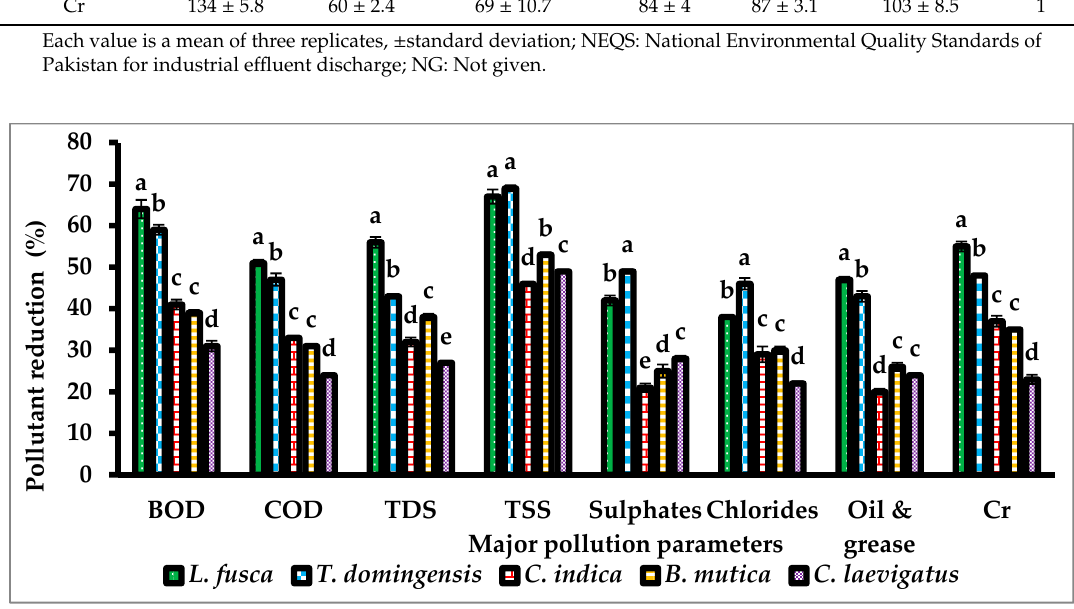
Figure 3. Pollutant reduction in tannery effluent by different macrophytes in constructed wetlands. Error bars indicate standard deviation among three replicates. Labels (a)–(e) indicate statistically significant differences ( p < 0.05) among plant species at a 5% level of significance.